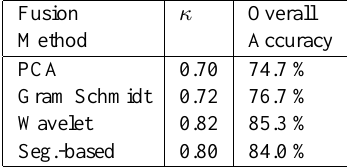
Table 4: Accuracy Measures of the Classification Results based on different Fusion